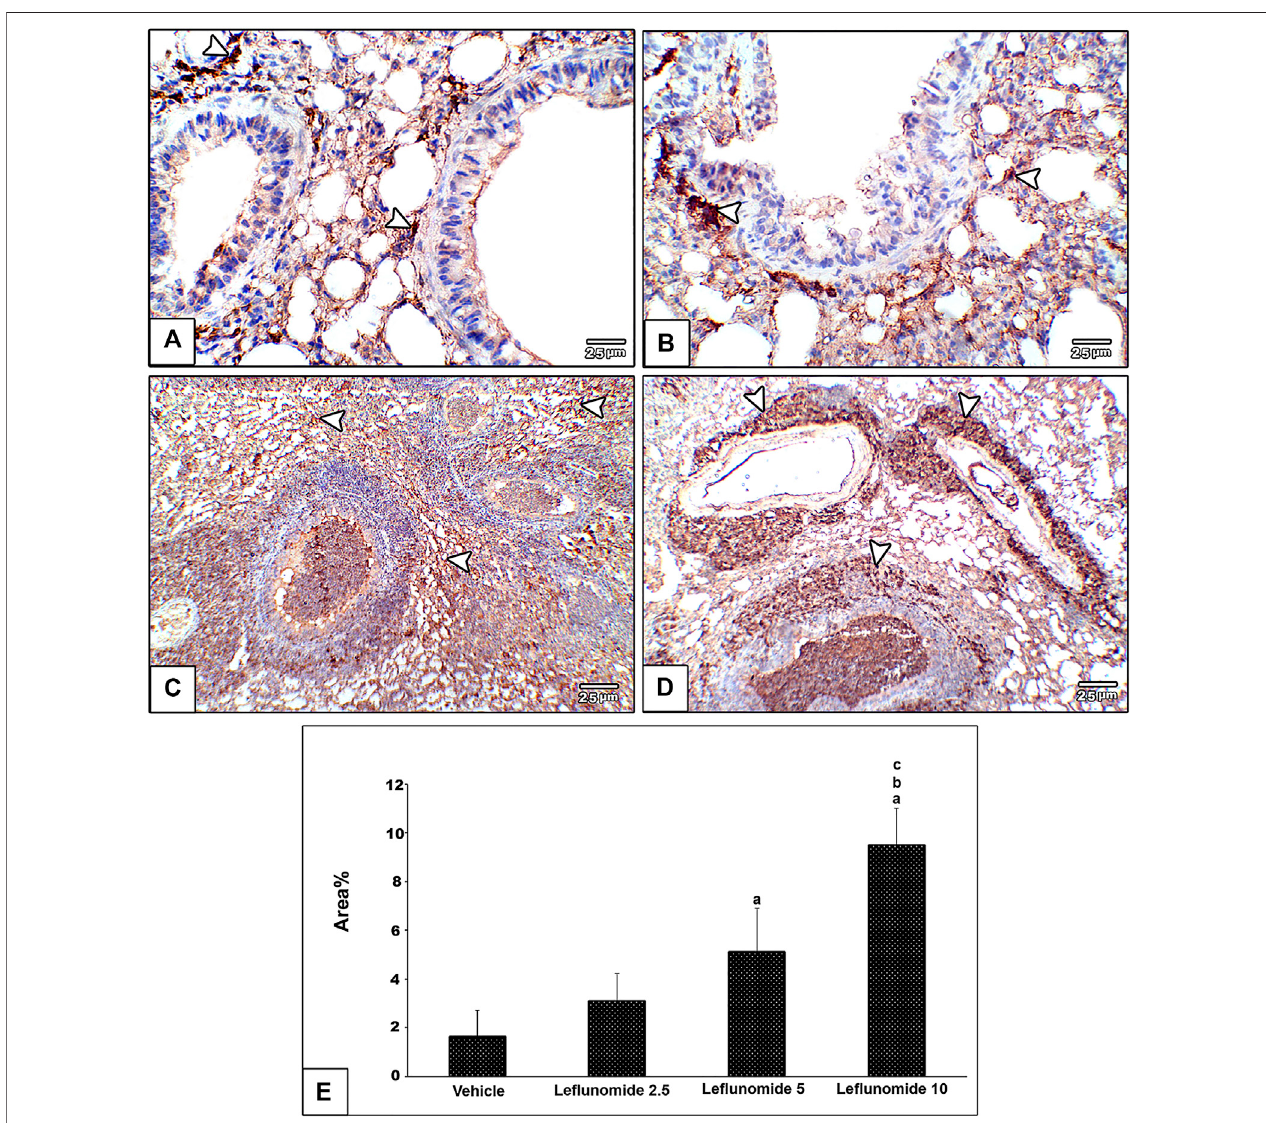
FIGURE 8 | Immunohistochemical staining of vimentin in lung sections (A) An image from the vehicle group shows weak expression of vimentin compared to moderately increased expression of vimentin in mesenchymal cells in inter alveolar septa, perivascular and peribronchiolar spaces in le fl unomide 2.5 group (B) , le fl unomide 5 group (C) and markedly increased in le fl unomide 10 group (D) (E) A column chart representing the mean area ± SDM, (A) : vs. vehicle group, (B) : vs. the le fl unomide 2.5 mg per kg group, (C) : vs. the le fl unomide 5 mg per kg group at p < 0.05.